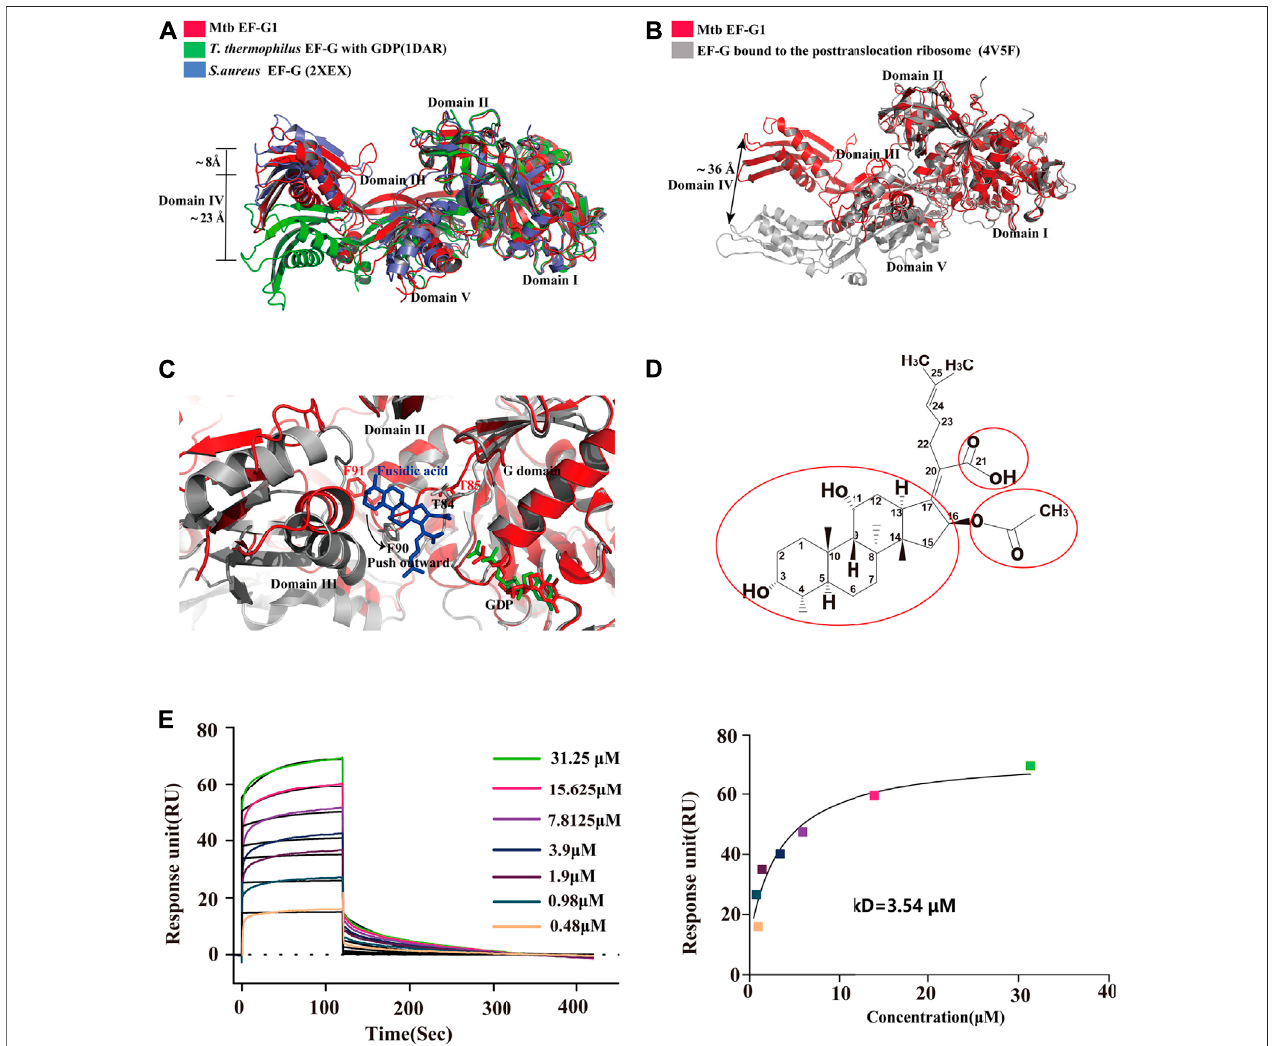
FIGURE 3 | Comparison of the structures of Mtb EF-G1 with EF-G from other species and EF-G trapped in the post-translocational ribosome. (A) Comparison of Mtb EF-G1 with T.thermophiles EF-G (PDB id:1DAR) and S.aureus EF-G (PDB id:2XEX) revealing movement of the tip of domain IV between Mtb EF-G1 and T.thermophiles EF-G,and betweenMtb EF-G1and S.aureus EF-G. Superposition wasachievedbyaligning domains IandIIofthetwoEF-Gstructures. DomainsofEF- Garelabeledwithlatinnumbers. (B) MtbEF-G1(red)andEF-Gboundtothepost-translocationalribosome(gray,PDBid:4V5F)superposedbystructuralalignment ofdomains IandII.Thearrow indicatestheshiftofthetipofdomain IVbetweenthetwostructures. (C) SuperpositionofdomainsIand IIbetweenthefusidicacid-bound structure(gray,PDBid:4V5F)withMtbEF-G1indicatesmovementoutwardordownwardoftheswitchIIregionbetweenthetwostructures. (D) ChemicalstructureofFA. Theessentialgroupsforactivityaremarkedwithredcircles. (E) SPRanalysisofFAbindingtoMtbEF-G1(left)FAatvariousconcentrationswereinjectedoverimmobilized Mtb EF-G1. (right) Fitting curve for equilibrium binding that produced a kD of 3.54 μ M.